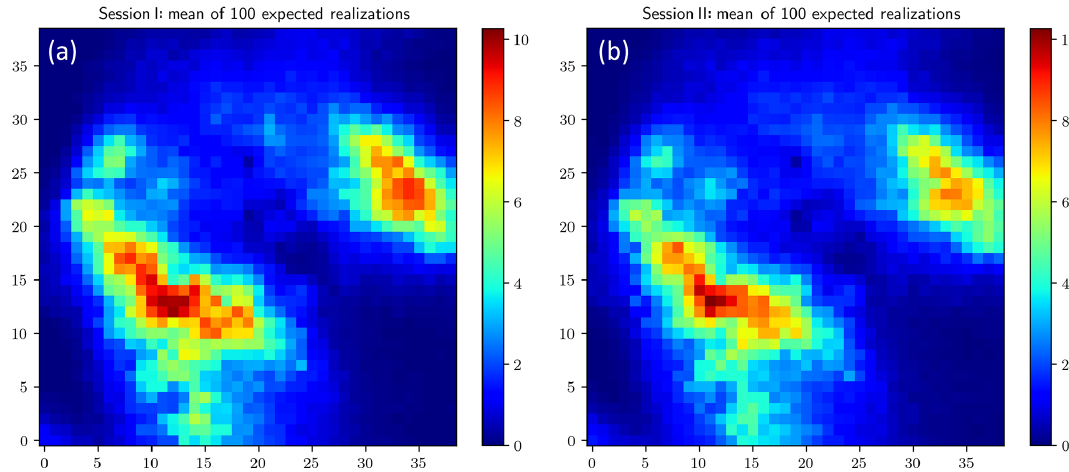
Figure 9. Mean of 100 expected realizations (mm) from Session I (a) and Session II (b)